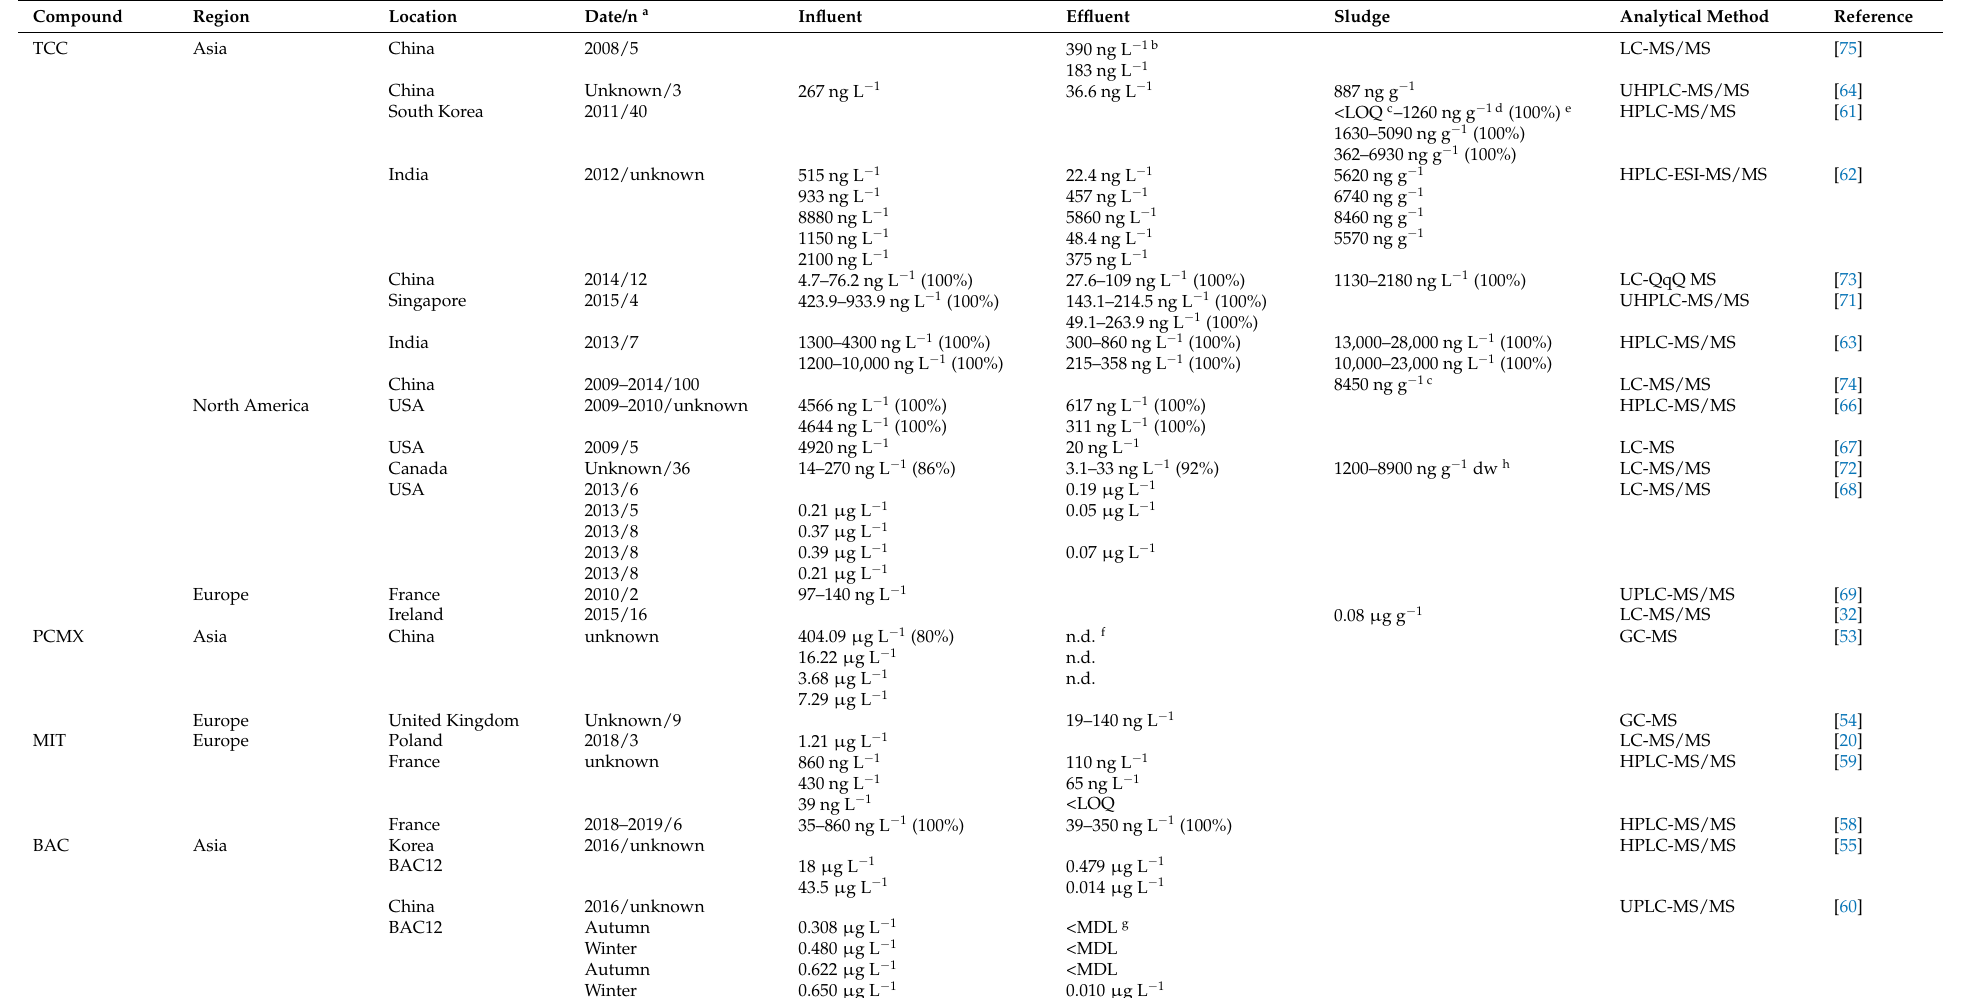
Table 2. Occurrence of preservatives in the wastewater treatment